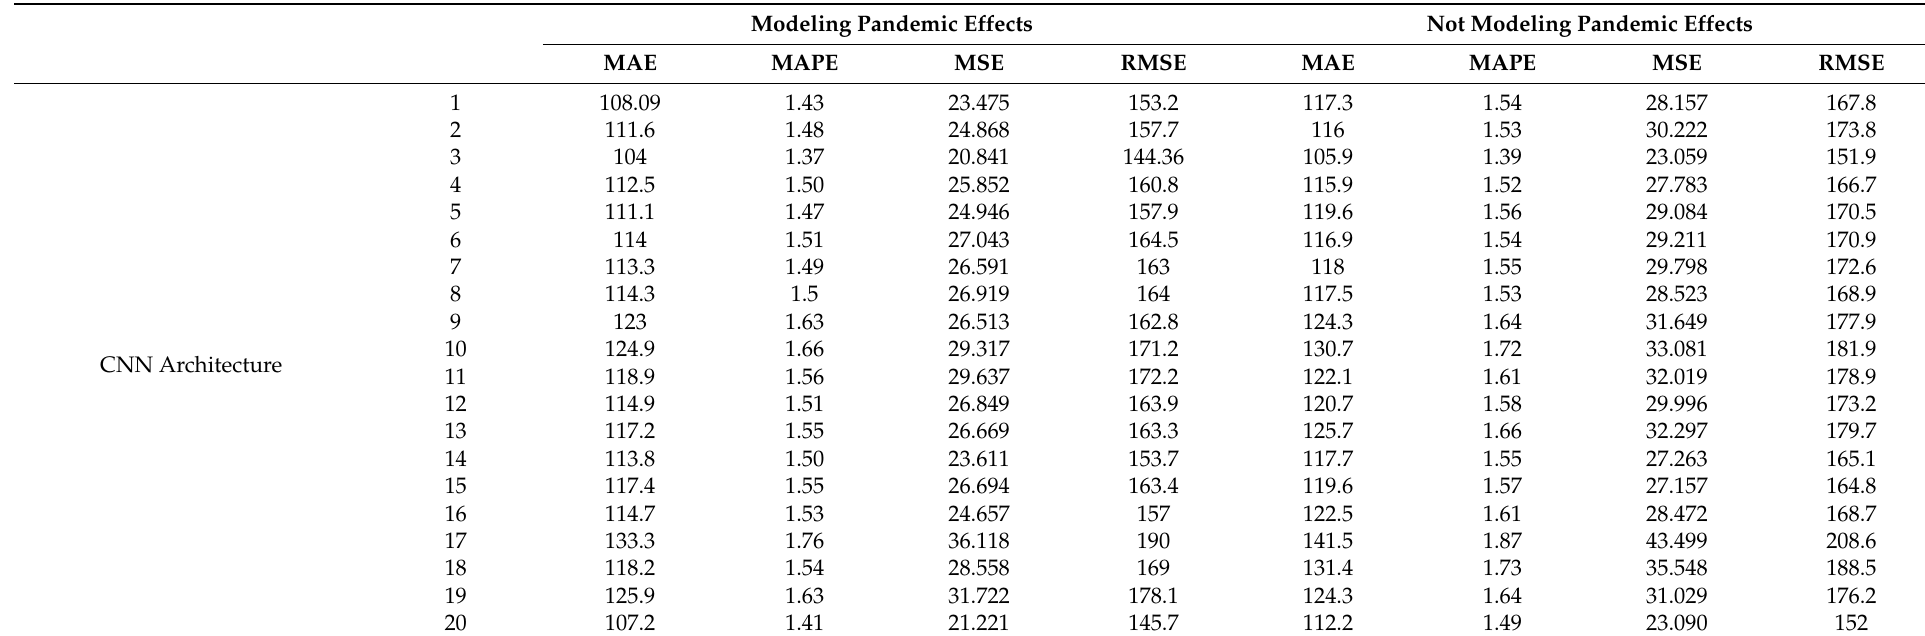
Table 4. Convolutional Neural Network (CNN) model performance for various